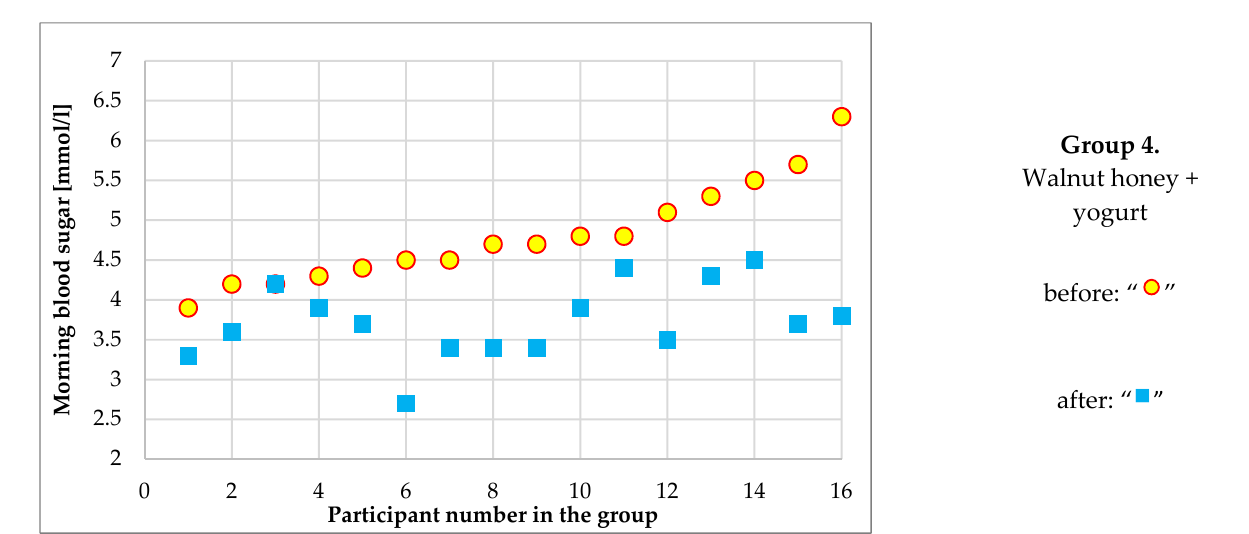
Figure 1. The blood sugar level of each participant in the four treatment groups of the clinical trial before (day 0) and after (day 21) of the trial. The participants received 30 g of four different honey products in 150 g of yogurt over 21 days. Some volunteers were excluded from the study from the first, second, and third groups because one had a high initial blood sugar level and the others gave up participation in the trial. In the fourth group, all of the participants took part from the beginning until the end.